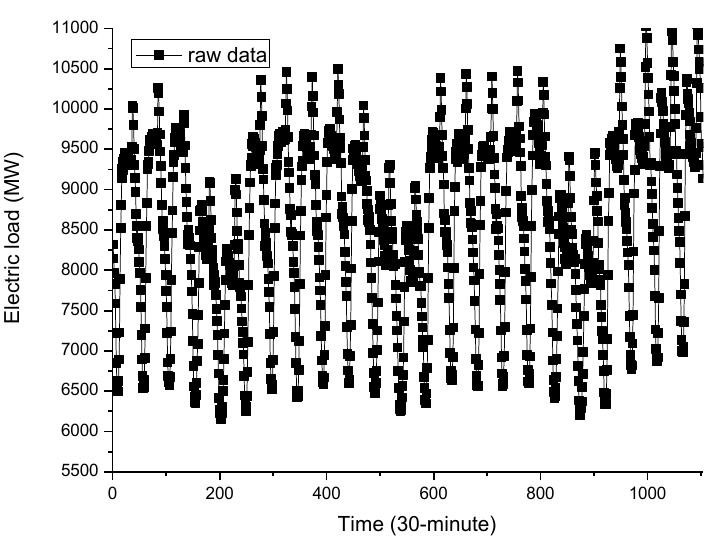
Figure 3. The raw data of the large sample data. Table 1. The optimized parameters of the SVR-PSO model for different items in both samples. Sample Size/Defined Items